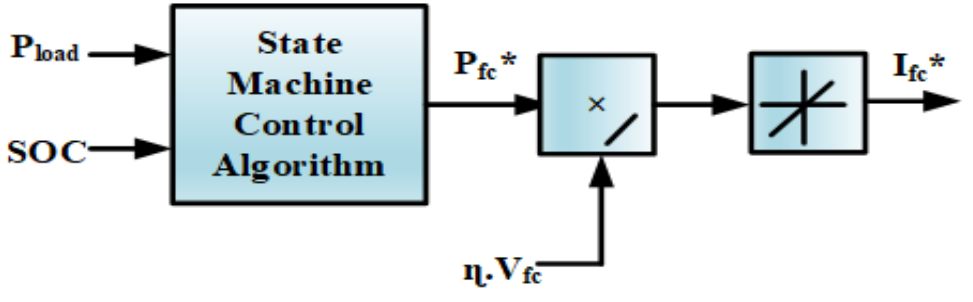
Figure 3. State machine control technique.